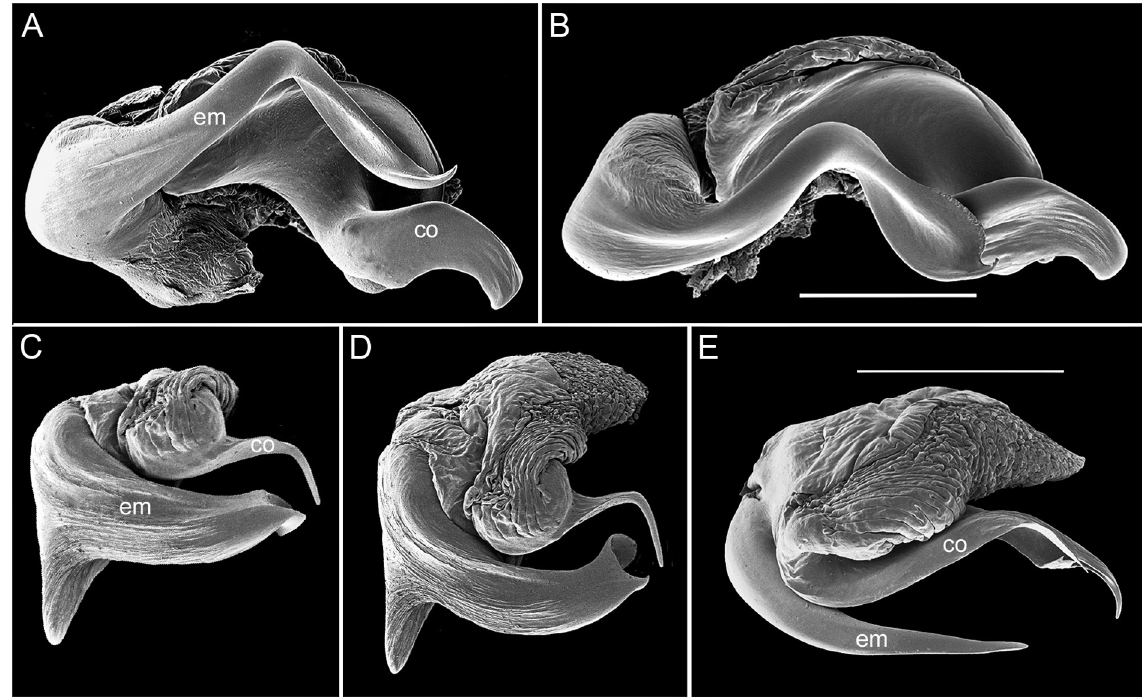
Fig. 5. Terminal part of left male palp with embolus ( em ) and conductor ( co ). — A . Wadicosa cognata sp. nov., from Kenya, Lake Magadi, ventral view. — B . W. fidelis (Pickard-Cambridge), from